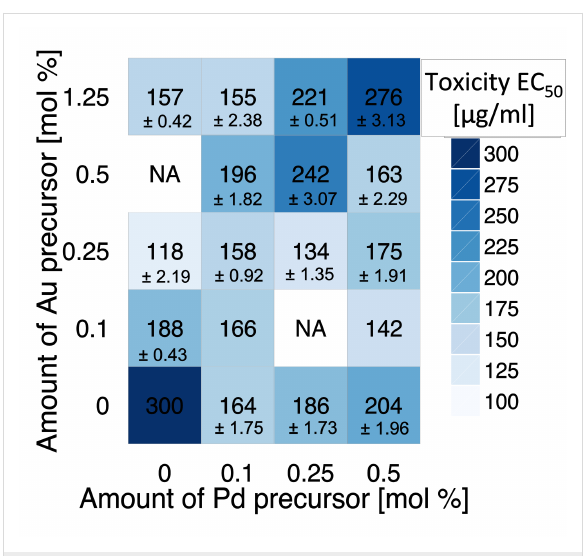
Figure 2: Cytotoxicity of TiO 2 modified with Pd and/or Au nanoparti- cles (NA: not available, these combinations were not